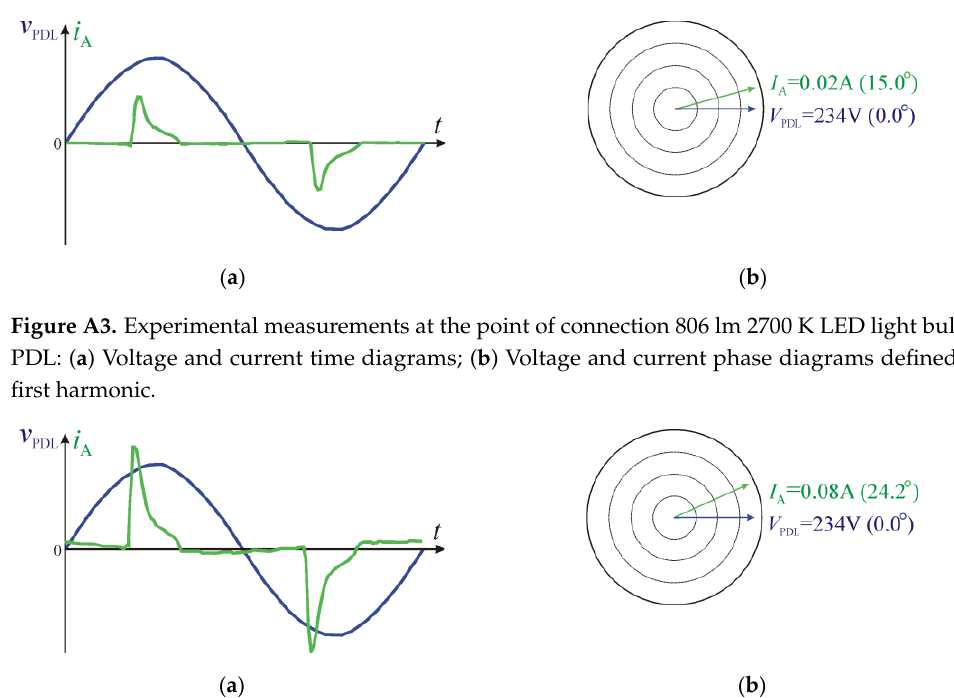
Figure A2. Photo of experimental setup for the reactive power provided by LED devices analysis.